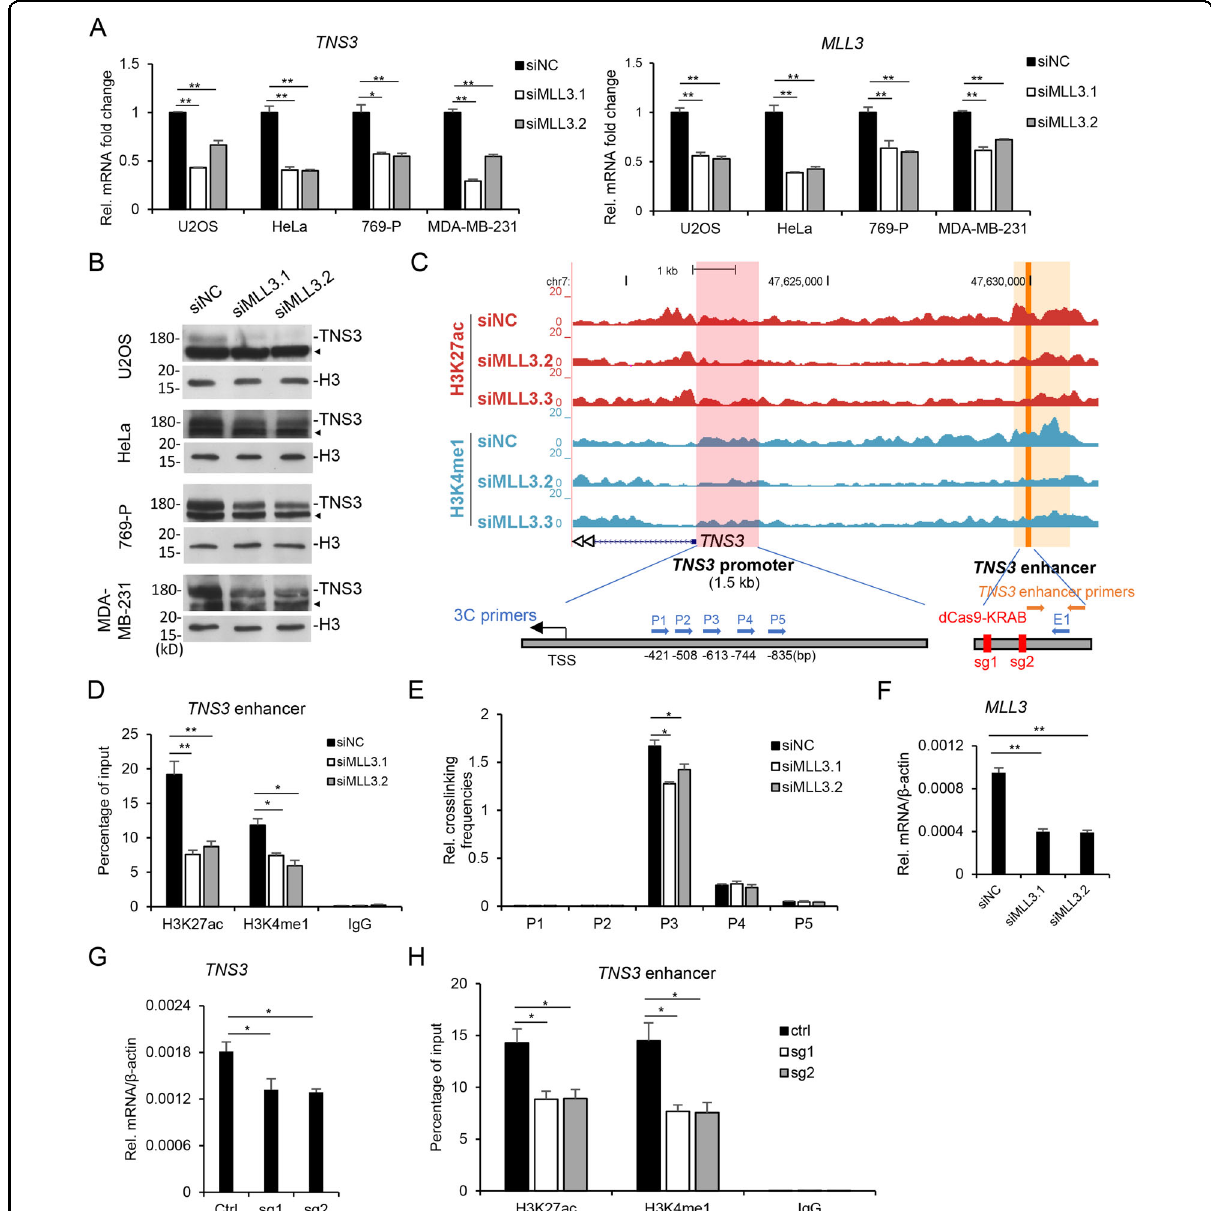
Fig. 4 MLL3 targets TNS3 enhancer. A MLL3 was knocked down with two different siRNAs in U2OS, HeLa, 769-P, and MDA-MB-231 cell lines. The mRNA levels of TNS3 and MLL3 were determined by qRT-PCR. B Cells were prepared as ( A ). TNS3 proteins were analyzed by western blotting. C The genome browser view showing H3K27ac and H3K4me1 enrichment on TNS3 promoter and enhancer regions after MLL3 knockdown. The TNS3 promoter and enhancer regions are highlighted in pink and orange respectively. The orange arrows indicate the loci of TNS3 enhancer primers. The blue arrows indicate the loci of 3C primers. The red bars indicate the loci targeted by dCas9-KRAB sgRNAs. D U2OS cells were prepared as ( A ) and ChIP qRT-PCR analysis was performed to determine the relative enrichment of H3K27ac and H3K4me1 (percentage of input) on TNS3 enhancer. E U2OS cells were prepared as ( A ) and 3C assay was performed. The relative crosslinking frequencies were determined by qRT-PCR. F MLL3 mRNA levels in the cells used in ( D ) and ( E ) were determined by qRT-PCR. G , H TNS3 enhancer activity was repressed by dCas9-KRAB/sgRNA system. TNS3 mRNA levels were determined by qRT-PCR ( G ) and ChIP assay was performed to measure the modi fi cations on the enhancer ( H ). All the data are presented as mean ± SD ( n = 3). * P < 0.05, ** P < 0.01. ◄ represents unspeci fi c